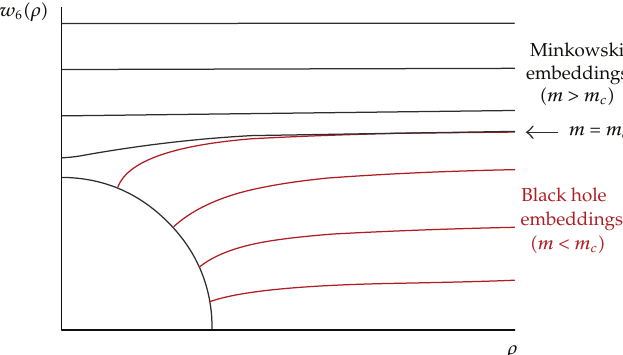
Figure 5: Two classes of regular solutions in the AdS black hole background.